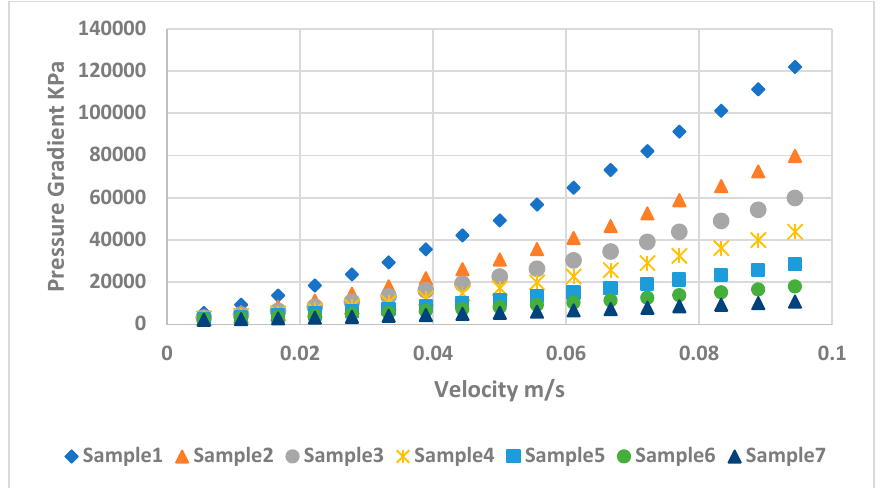
Figure 8. Pressure Gradients vs. Velocity.